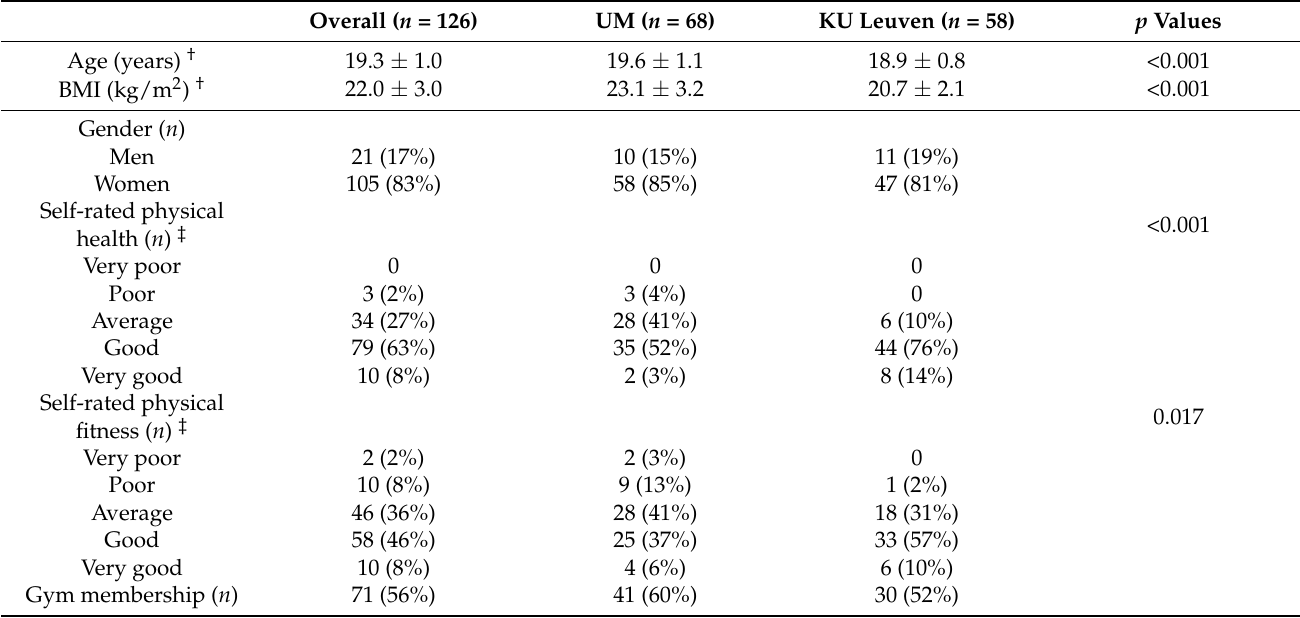
Table 1. Demographic characteristics of UM and KUL students.